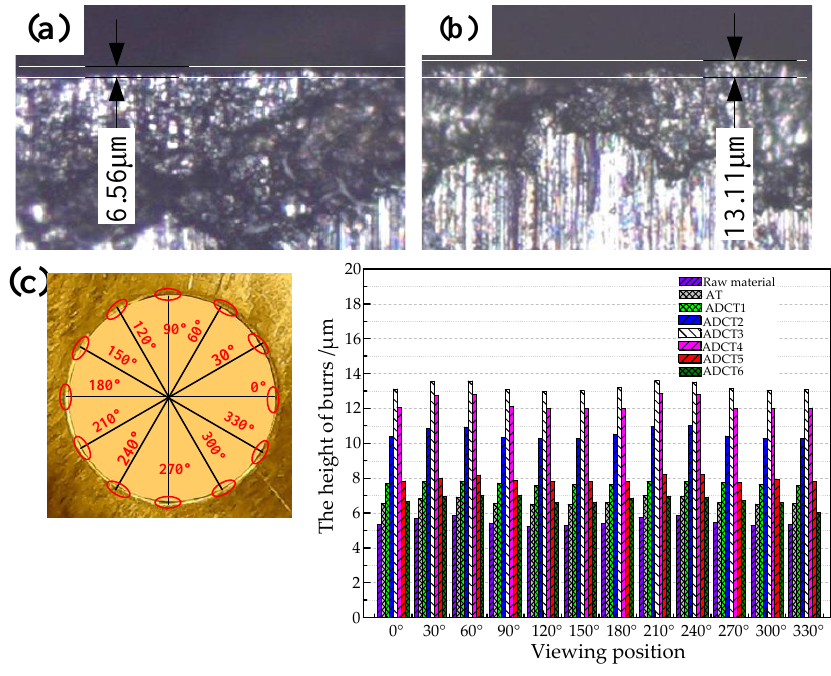
Figure 11. Change of the burrs: ( a , b ) example of measured results; ( c ) measured position and changes in the heights of burrs.